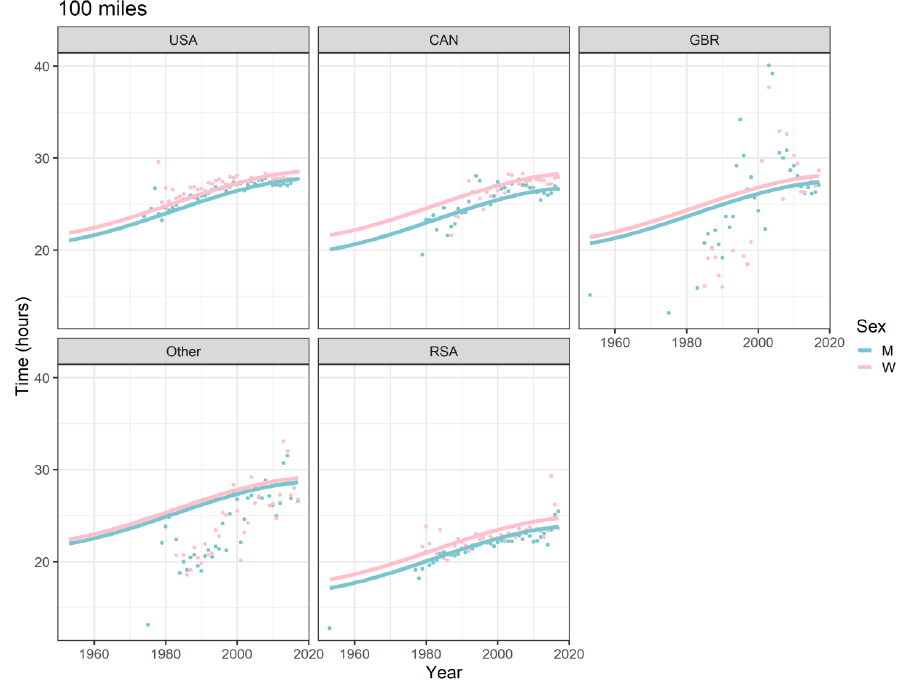
Figure 4. Ultra-marathon speed, 100 miles, by sex, calendar year, and country. Points are race-time averages. Lines are fitted curves (mixed model). Vertical lines with numeric labels are the ages at peak performance. USA = United States of America, CAN = Canada, GBR = Great Britain, RSA = Republic of South Africa, W = women, M = men.